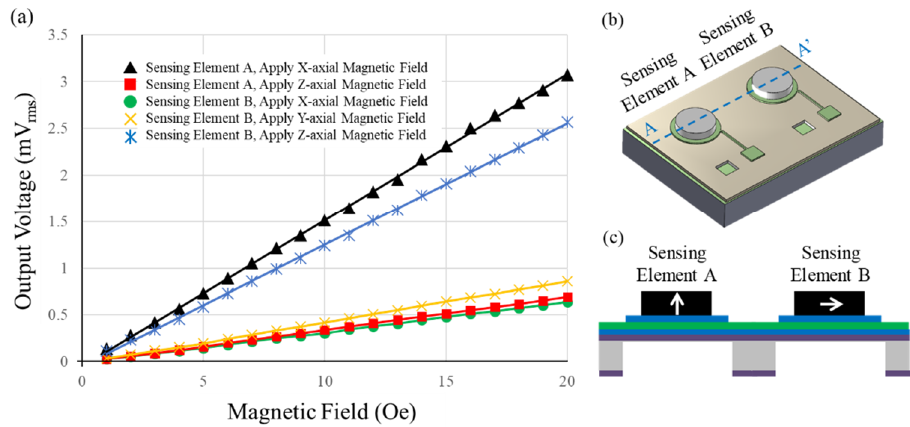
Figure 9. The sensing results of the three-axial AC magnetic fields with a frequency of 7.5 kHz: ( a ) the testing results, ( b ) the isotropic-view illustration of two sensing elements, and ( c ) the AA’ cross-section-view illustration of two sensing elements with different magnetization directions of the Ni thick films. Table 2. The sensitivity of sensing elements A and B, when applying three-axial AC magnetic fields to the sensor.